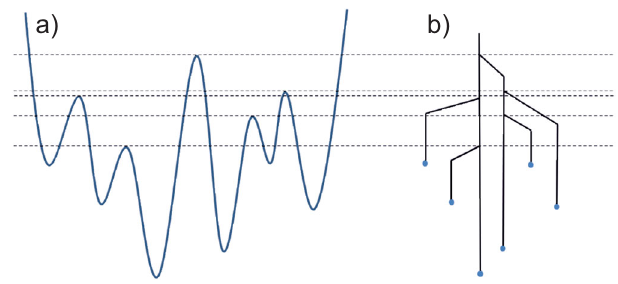
Fig. 2 Disconnectivity graph. An example of tree-like representation ( b ) of an example energy landscape (